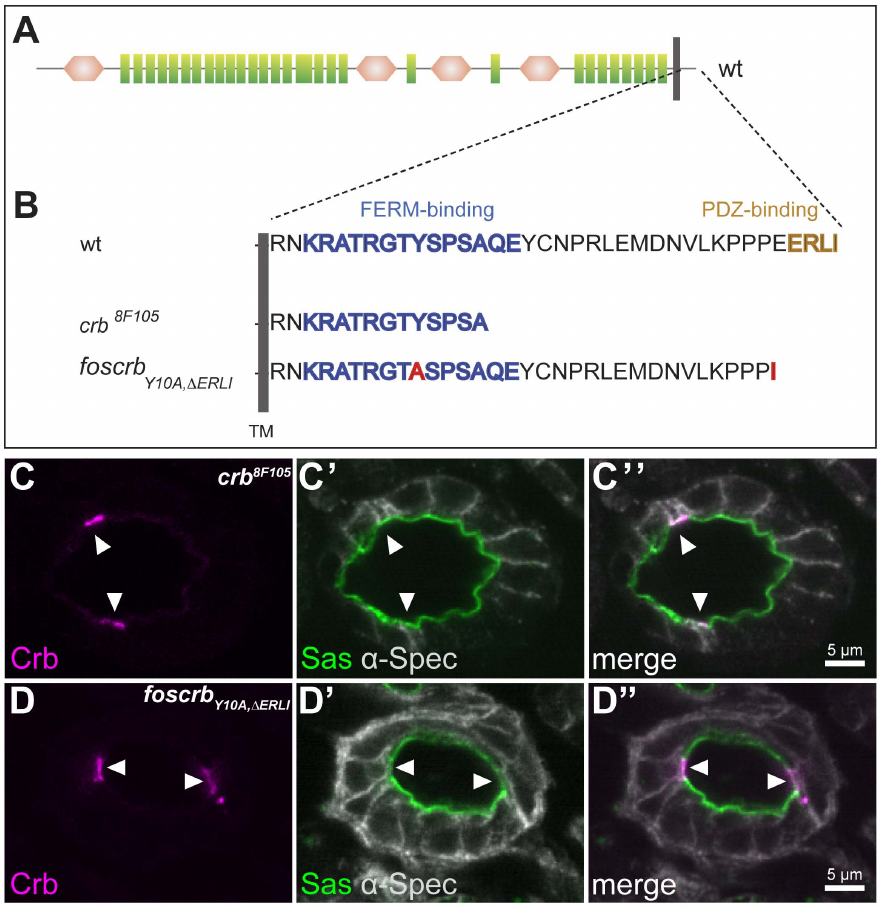
Figure 4. Localisation of Crb in BCs is independent from its known protein binding motifs. ( A ) Schematic representation of the Crb protein and its variants used in this study. Green rectangles: EGF-like repeats, brown hexagons: laminin A G like domains, grey bar: transmembrane domain (TM). ( B ) Amino acid sequences of the cytoplasmic tails of wild-type and mutant Crb proteins used in this study. Blue: FERM domain-binding motif, brown: PDZ domain-binding motif. Red: point mutations. ( C–D 0 ) Confocal microscopy images of cross sections through the large intestine of stage 15 homozygous crb 8F105 (C–C 0 ) and foscrb Y10A, D ERLI (D–D 0 ) embryos stained with anti-Crb (magenta), anti- a -Spectrin (grey) and anti-Sas (green). Crb is upregulated and apically localised in the BCs (white arrowheads), but is not detectable in the